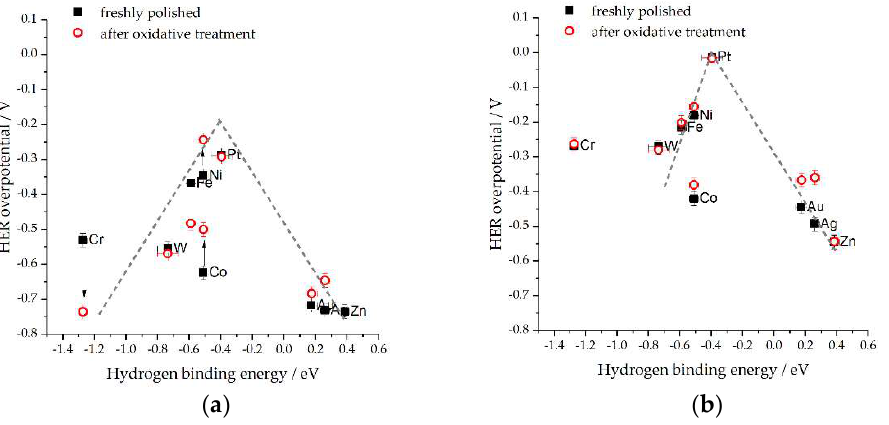
Figure 2. The HER volcanoes in neutral media: ( a ) 0.5 mol dm −3 NaCl (simulated sea water); ( b ) 1 mol dm −3 KH 2 PO 4 (in both cases, pH was adjusted to 7.0). Squares represent freshly polished electrodes, while circles are for the electrodes after oxidative treatment. In the case of the NaCl solution, arrows indicate the most prominent activity changes.